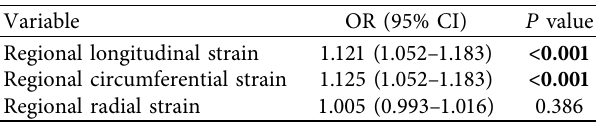
Table 2: The results of logistic regression analysis on the predictive role of regional strain values for regional